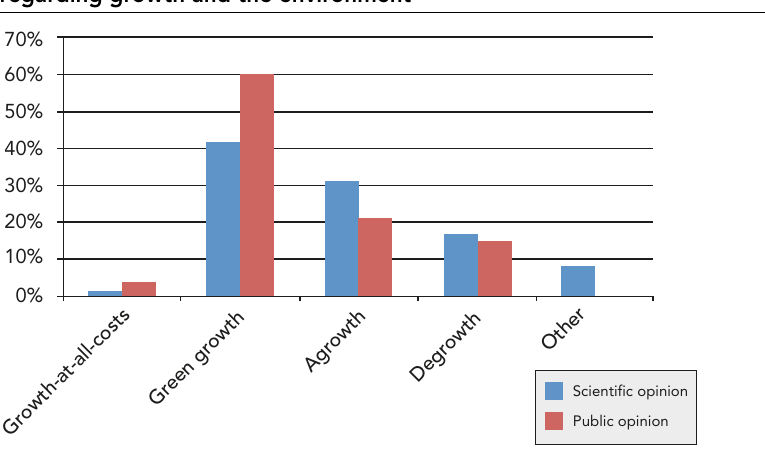
Figure 1. Scientists’ versus citizens’ preferences for a public policy